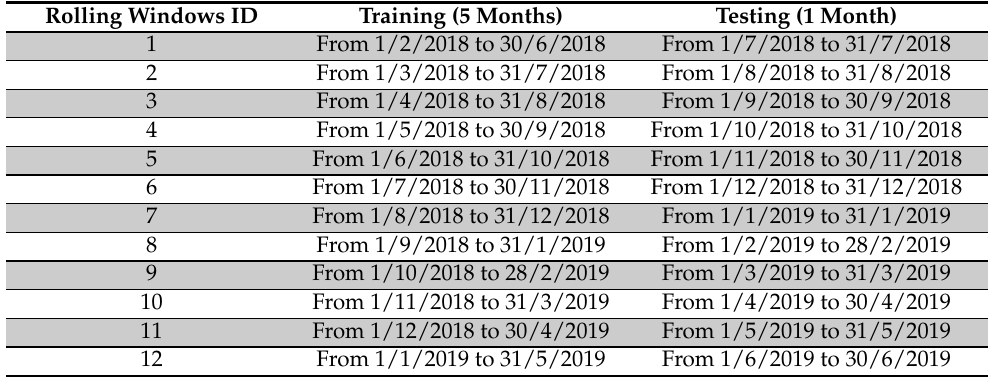
Table 8. The genetic algorithm settings for feature selection. Setting Value Size of population 500 Crossover type Single point Crossover rate 100% Mutation rate 40% Number of genes subjected for mutation 7 within each chromosome 10 successive iterations with less than 0.5% Stop criteria increasing in accuracy Objective function Accuracy Number of genes in one